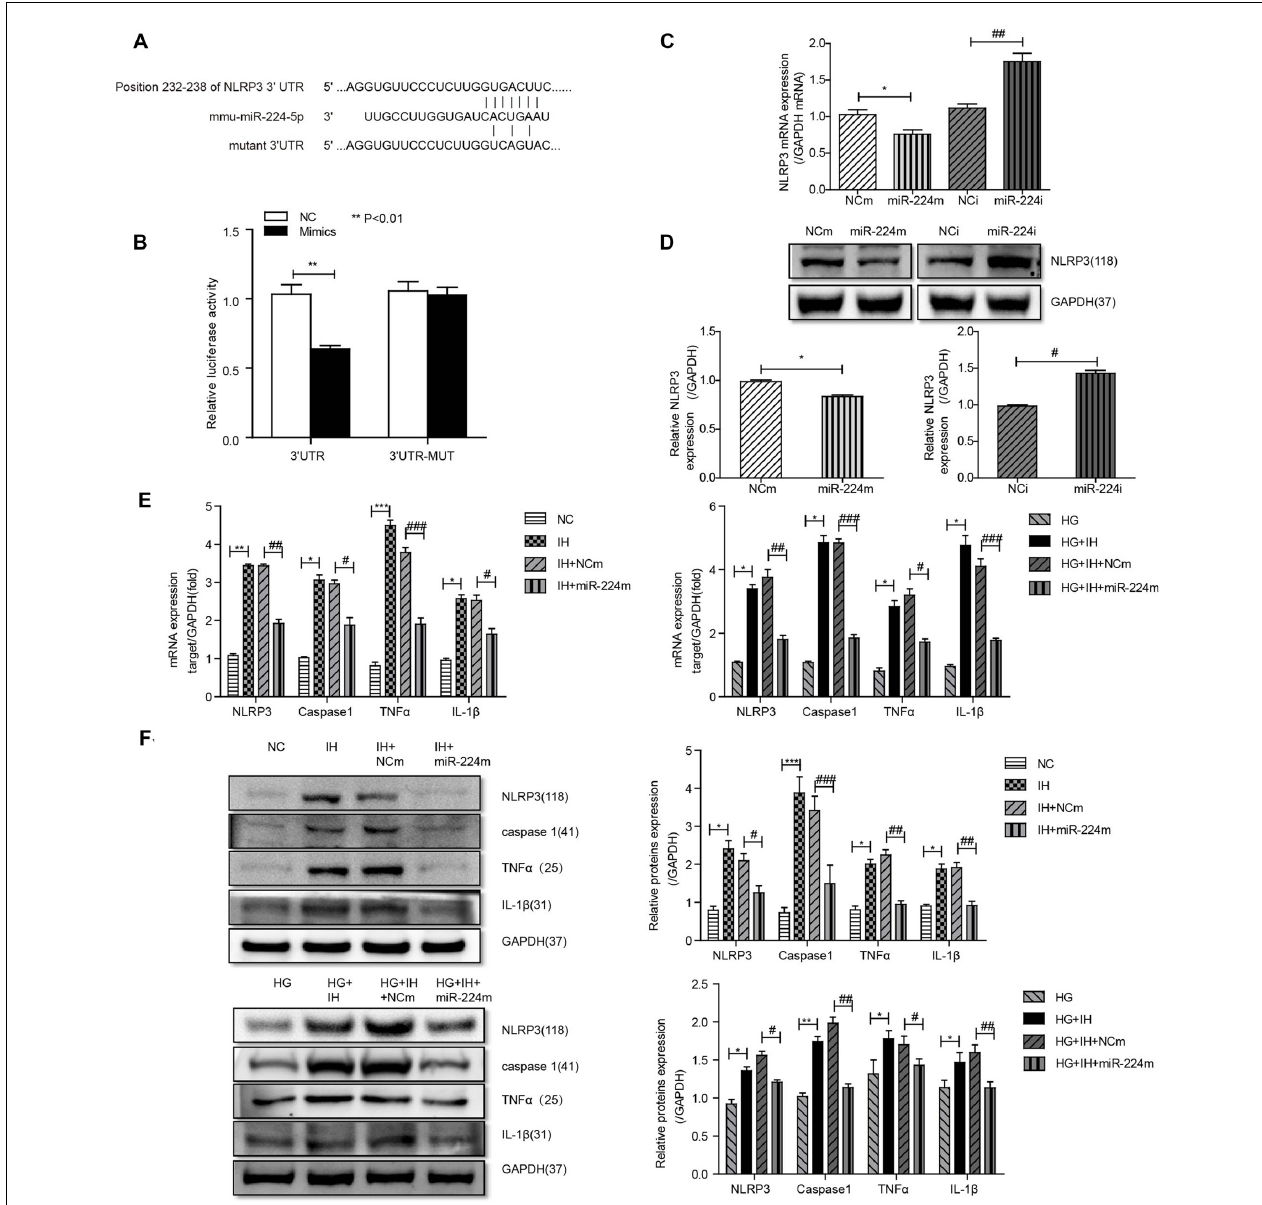
FIGURE 5 | Inhibition of the MALAT1/miR-224-5p/NLRP3 axis reduced inflammation caused by exposure to IH and HG. (A) Sequence alignment between miR-224-5p and the 3 (cid:48) -untranslated region (UTR) of NLRP3. Complementary bases between the sequences are shown in red. The sequence of the mutant NLRP3 construct is also shown. (B) Firefly luciferase assay of BV2 cells co-transfected with NLRP3 3 (cid:48) -UTR-WT or NLRP3 3 (cid:48) -UTR-Mut and miR-224-5p mimic or miR-NC. Data are presented as the mean ± SD from six separate experiments. ** p < 0.01. (C,D) After the transfection of mimics and inhibitor, the mRNA expression and protein expression of NLRP3 was determined by qRT-PCR (C) and western blotting (D) . (E,F) NLRP3, caspase 1, TNF- α and IL-1 β expression levels in different groups of BV2 cells were detected by qRT-PCR (E) and western blotting (F) . * p < 0.05, ** p < 0.01, *** p < 0.001 vs. the NC group; # p < 0.05, ## p <